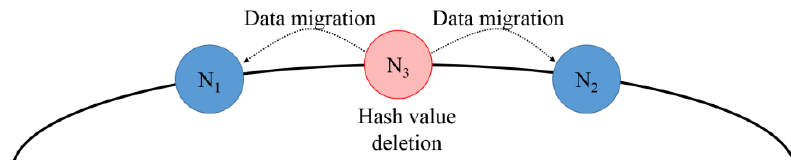
Figure 9. Deleting the hash value of an underloaded node.